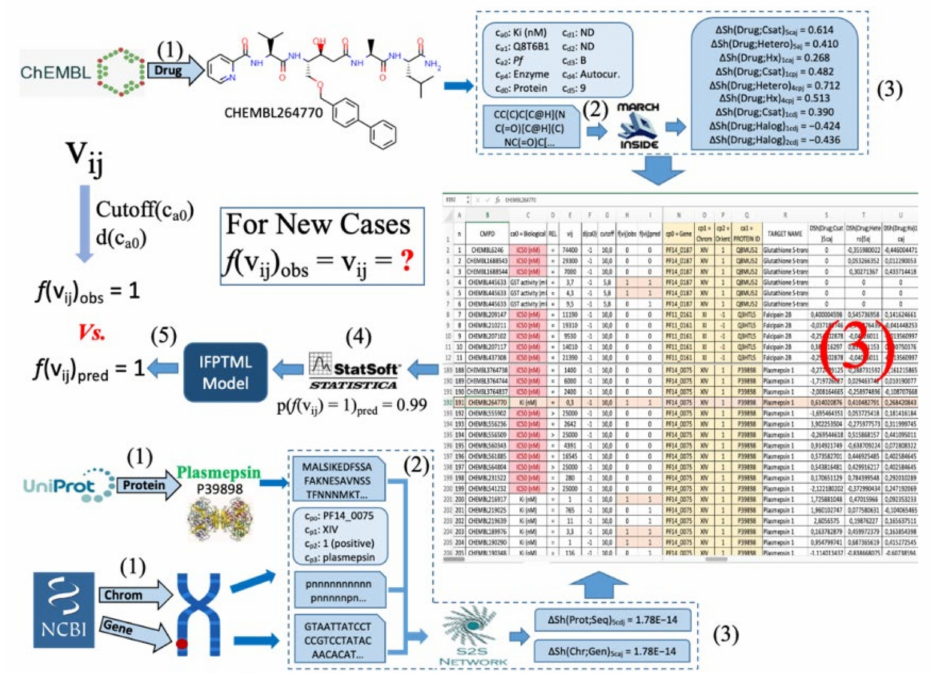
Figure 5. An example of the IFPTML-CTLC